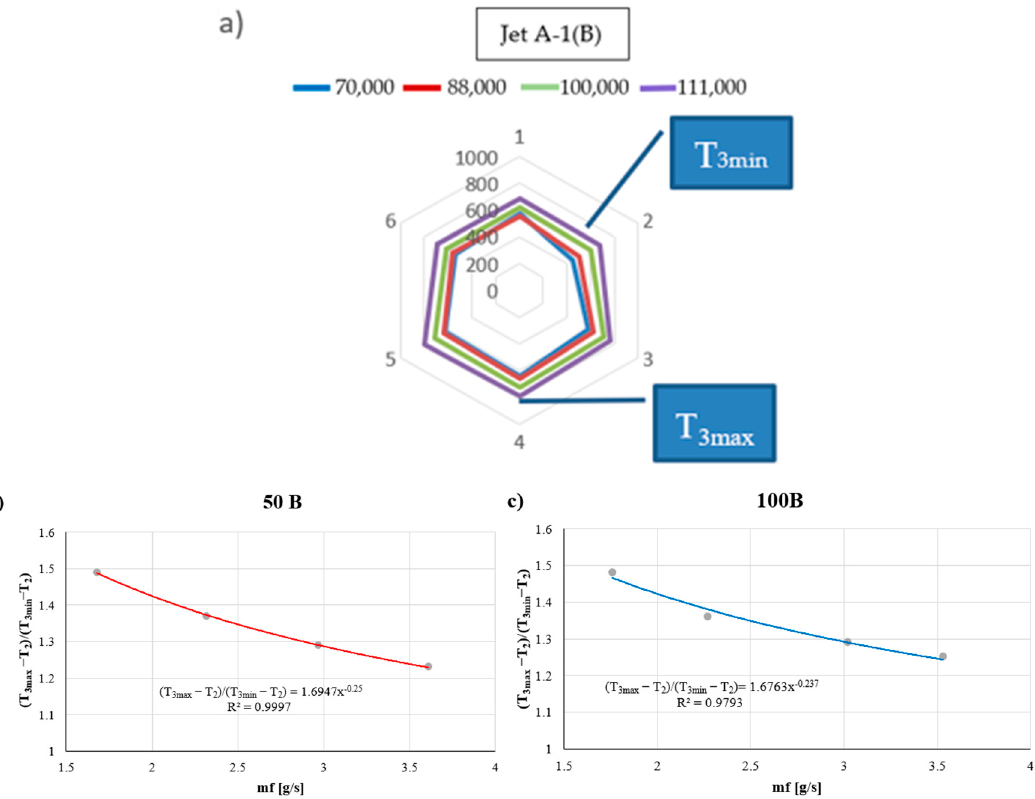
Figure 9. Dependence examples: ( a ) T 3 temperature distribution in the combustion chamber; ( b ) and ( c ) are examples of the (T 3max − T 2 ) / (T 3min − T 2 ) dependence on m f .